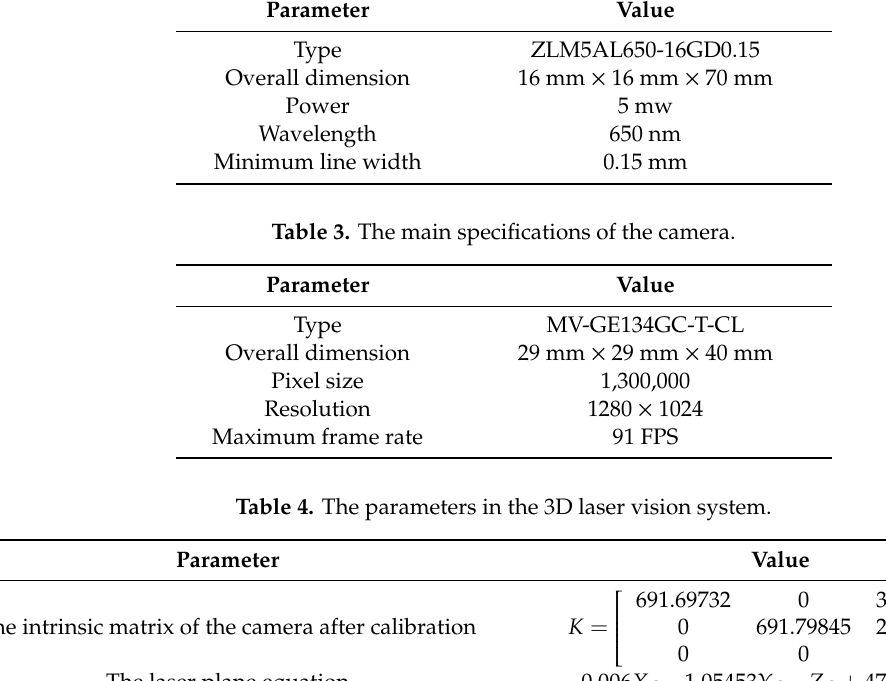
Table 2. The main specifications of the line laser.